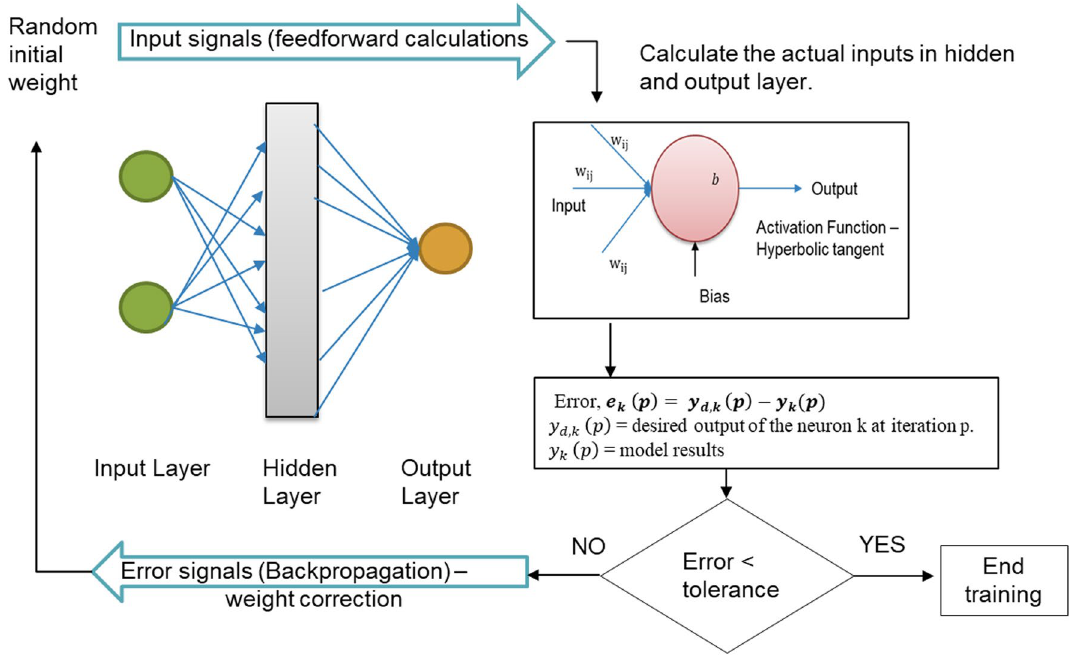
Fig. 2 Development of ANN